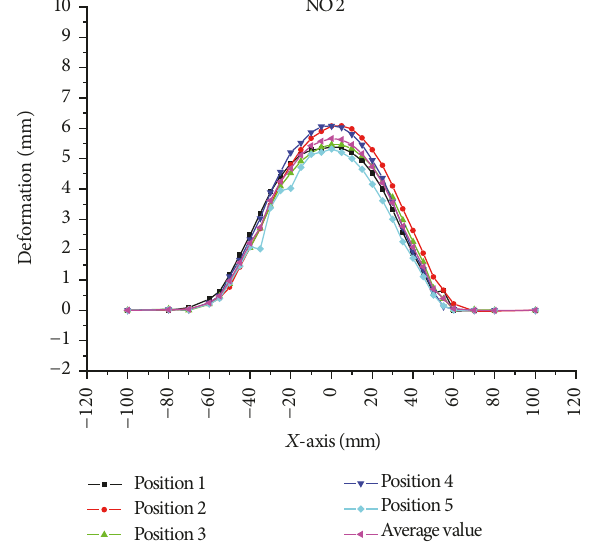
Figure 6: Deformation of the tube.